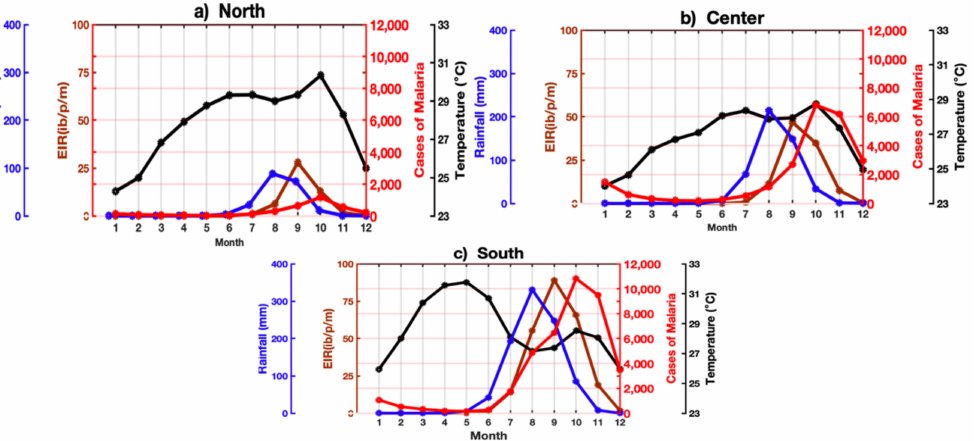
Figure 10. Comparison of the mean annual cycle between observed malaria cases and the EIR by agro-climatic zones in Senegal for 2009–2019: north zone ( a ), center zone ( b ), and south zone ( c